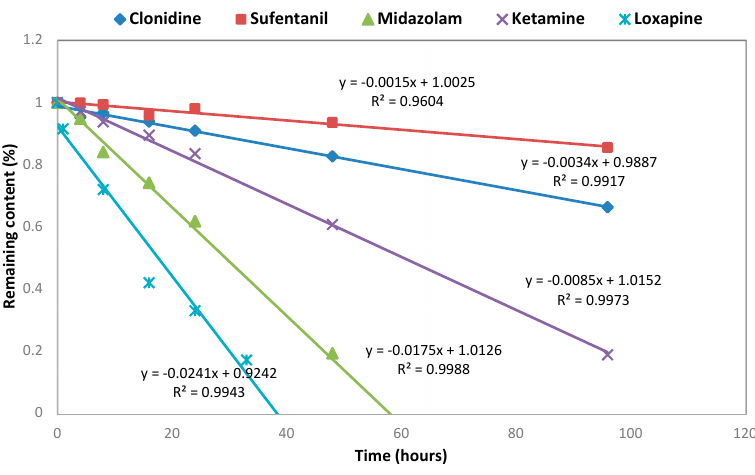
Figure 2. Degradation kinetic under oxidative conditions.